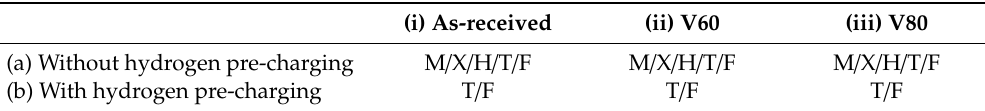
Table 2. Investigation conditions for AISI 430 steel: M stands for microstructural analysis, X stands for XRD analysis, H stands for microhardness test, T stands for tensile test, and F stands for fractography analysis.